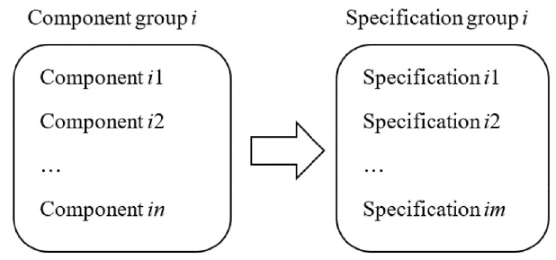
Figure 4 Searching for specification